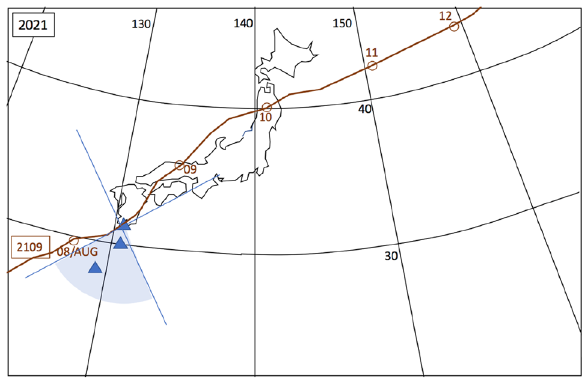
Figure 4. Meteorological history of tropical cyclons T-2109 48 . This figure is drawn, same with Fig. 2. HKMT drew the map with Microsoft PowerPoint software and HKMT drew the image with Microsoft PowerPoint software and holds the